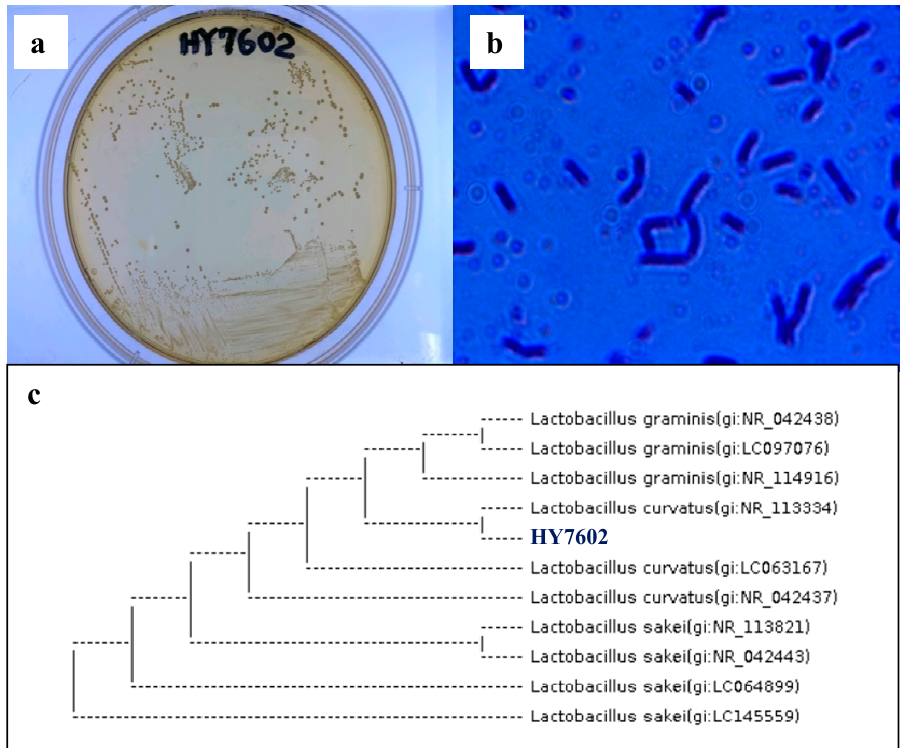
Figure 1. Morphological characteristics and phylogenetic tree depicting the taxonomic position of Lactobacillus curvatus strains based on 16S rRNA sequences. The lactic acid bacteria HY7602 were inoculated onto MRS plates, incubated at 37 °C for 36 h, and examined under a microscope. ( a ) HY7602 colonies. ( b ) HY7602 cells (4000X). ( c ) The 16S rRNA gene sequence of HY7602 was used to identify its respective phylogenetic position. A phylogenetic tree was constructed using a neighbor-joining method. The “T” after the collection number indicates the strain type of the species.